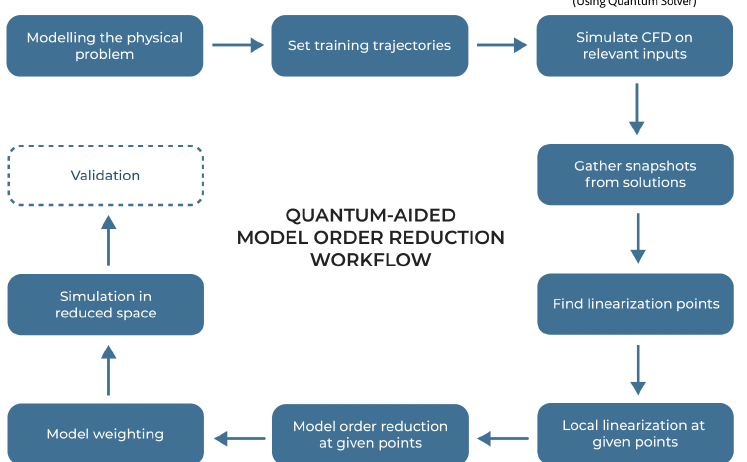
Figure 5. Visualization of the proposed quantum-aided model order reduction method highlighting the different steps in the workflow. This method can be used to generate linearized reduced-order models for efficiently solving complex simulations approximately with a high accuracy on classical computers. It is a combination of quantum and classical algorithms, where a quantum algorithm is used for solving the originally large problem in the offline training phase, with the results being post-processed by classical MOR